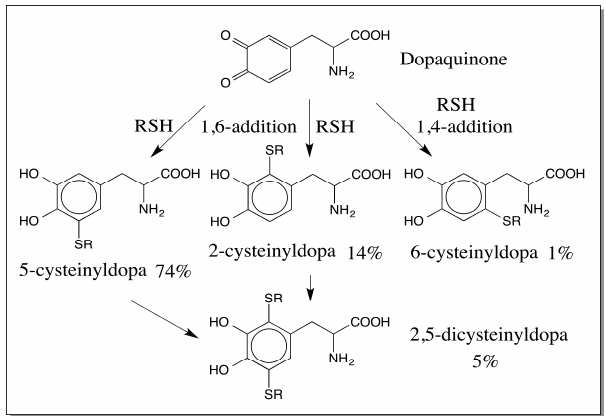
Figure 10. Thiol addition to dopaquinone. Thiols such as cysteine add on to dopaquinone not by conventional Michael-1,4-addition reaction. They react by an unconventional 1,6-addition, producing 5- S -cysteinyl dopa as the major product and 2- S -cysteinyldopa as the minor product. In addition 2,5-dicysteinyldopa is also formed to a certain extent. RSH—Cysteine. The thiolated catechols are further oxidized to their corresponding quinones most likely by the endogenous dopaquinone. The cysteinyl amino group is situated in a suitable position to form a cyclic adduct. This reaction gives rise to a quinone imine that could either undergo decarboxylative